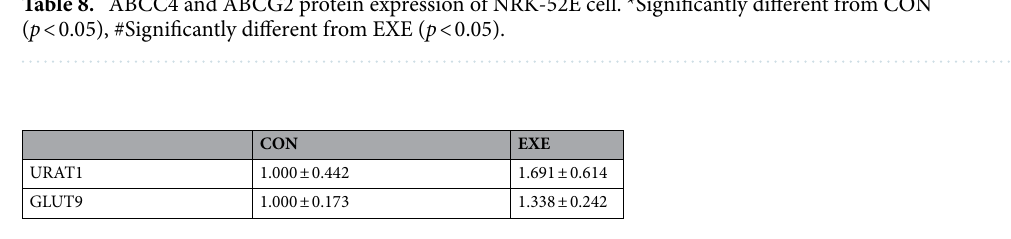
Table 9. URAT1 and GLUT9 protein expression of rat’s kidney. *Significantly different from CON ( p < 0.05).